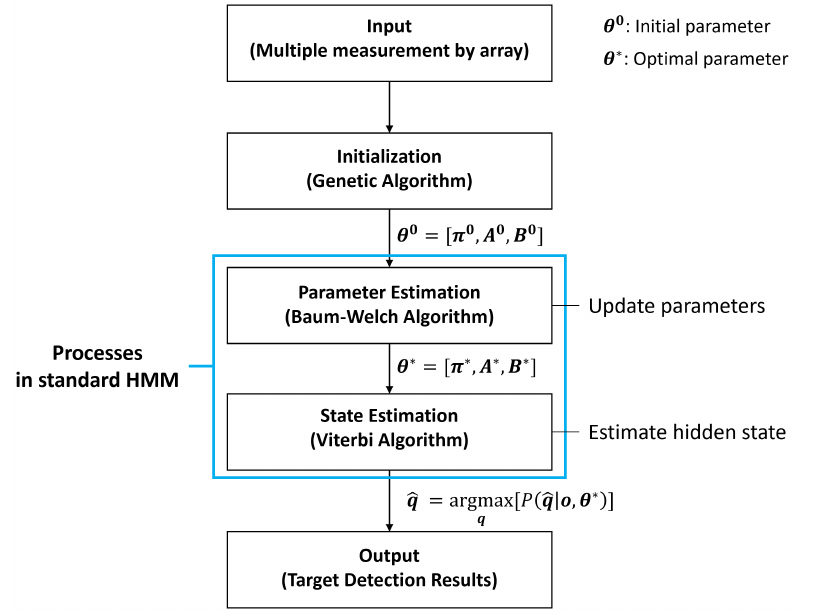
Figure 2. Block diagram of detection process in hidden Markov model (HMM). Multiple measure- ments were exploited to determine the best initial values for the HMM parameters using the genetic algorithm. They were updated with the Baum–Welch algorithm using the multiple measurements. Then, hidden states of the multiple measurements were revealed via the Viterbi algorithm using the HMM